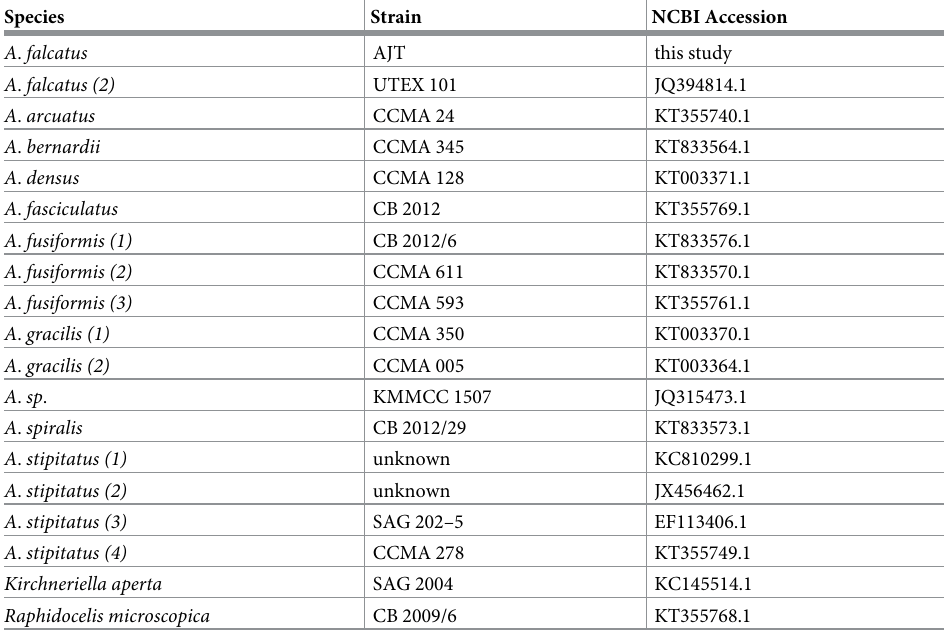
Table 3. Taxa, strain, and NCBI accession numbers of sequences used to evaluate genetic distances of rbcL among Ankistrodesmus